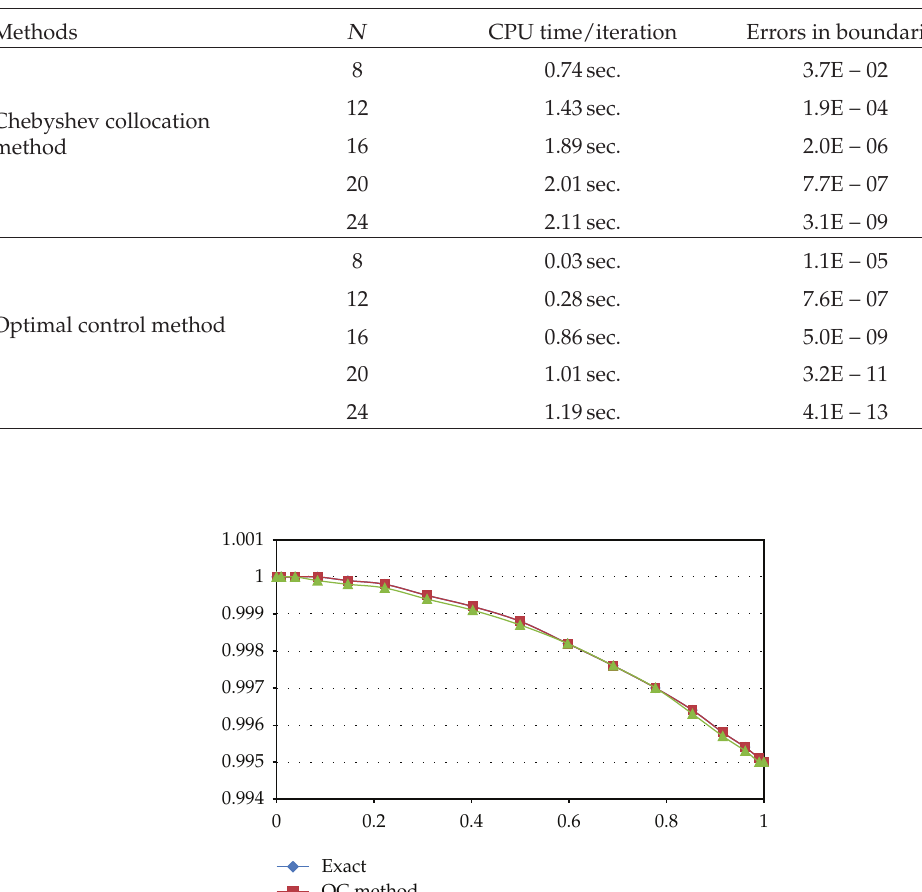
Table 2: Observed results for Example 4.2.